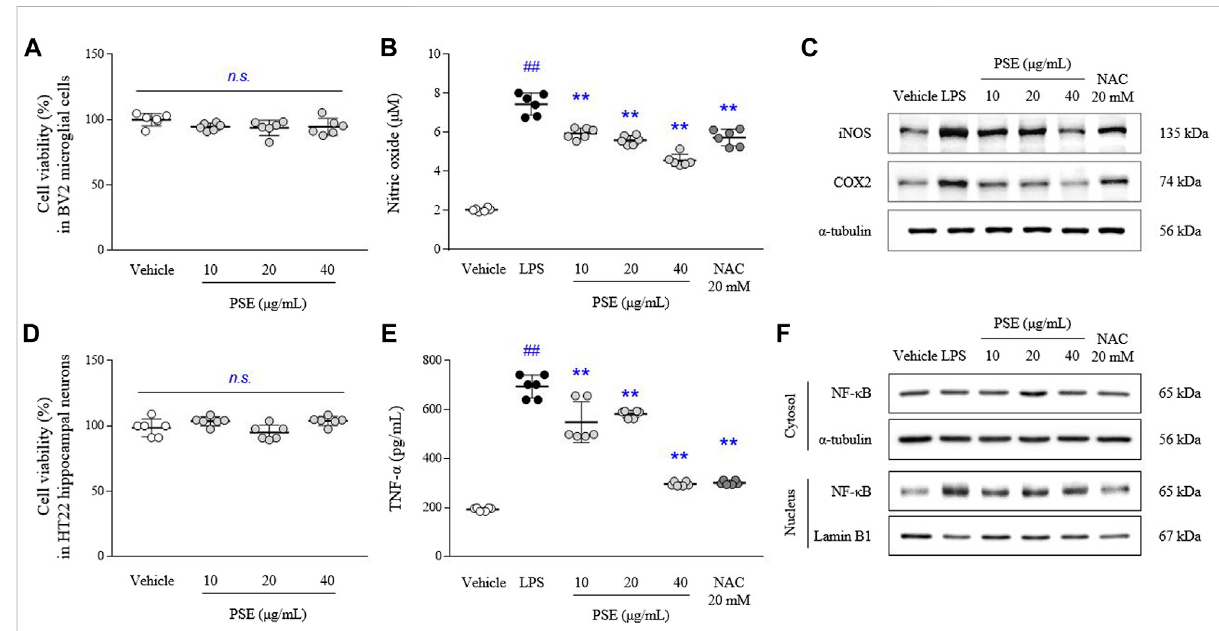
FIGURE 2 Cell cytotoxicity, NO, TNF- α and their-related molecules. BV2 and HT22 cells were treated with PSE for 24 h, or pretreated with PSE for 2 h before exposure to LPS (1 μ g/ml) for 24 h (only BV2). The cytotoxicity of PSE was assessed using a WST-8 assay in BV2 (A) and HT22 (D) cells. The levels of NO (B) and TNF- α (E) , the protein expression of iNOS and COX2 (C) , and the cytosolic and nuclear levels of NF- κ B (F) were measured. The data are expressed as the mean ± SD. ## p < 0.01 compared with the vehicle-treated cells; ** p < 0.01 compared with the LPS-stimulated